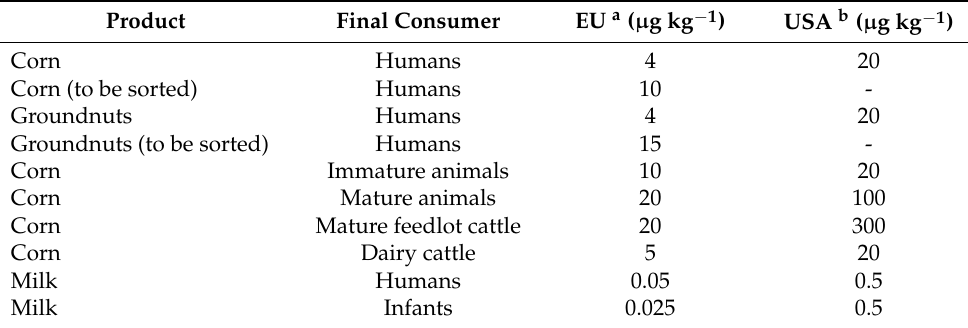
Table 1. Maximum levels for aflatoxin contaminants in food- and feedstuffs in European Union and United States of